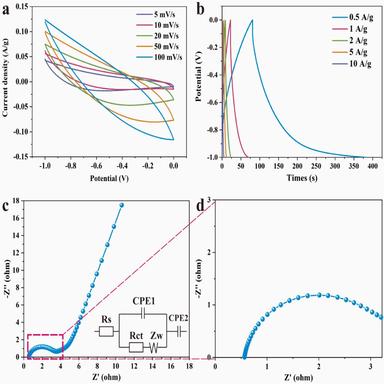
Electrochemical tests of single SPCM electrodes with a three-electrode device. (a) CV curves (the scanning rates of 5–100 mV s − 1 ), (b) GCD curves (the current densities of 0.5–10 A g− 1 ), (c) Nyquist diagram of SPCM, (d) Equivalent circuit plot.